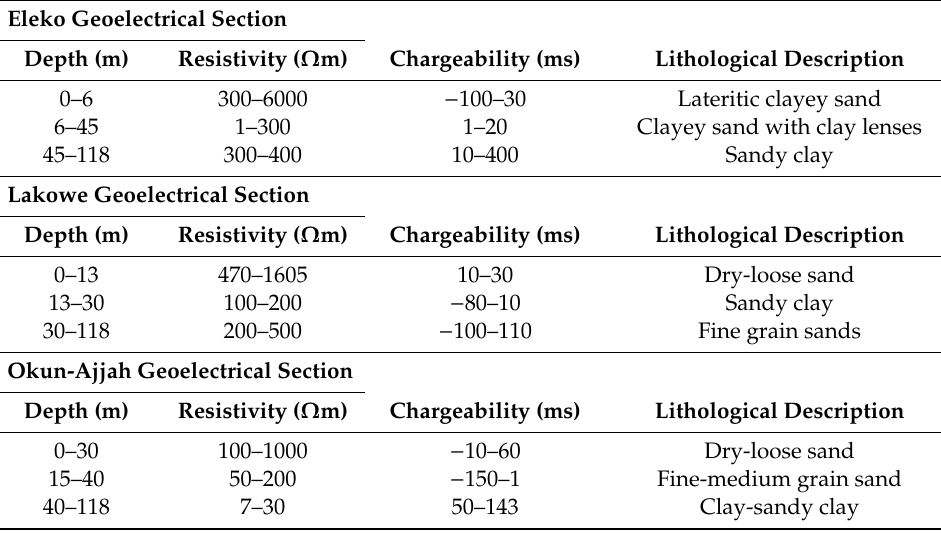
Figure 15. Litho-log from electrical resistivity tomography (ERT) and IP from Profile E–F. Table 6. Lithological interpretation of geoelectrical sections from Profile